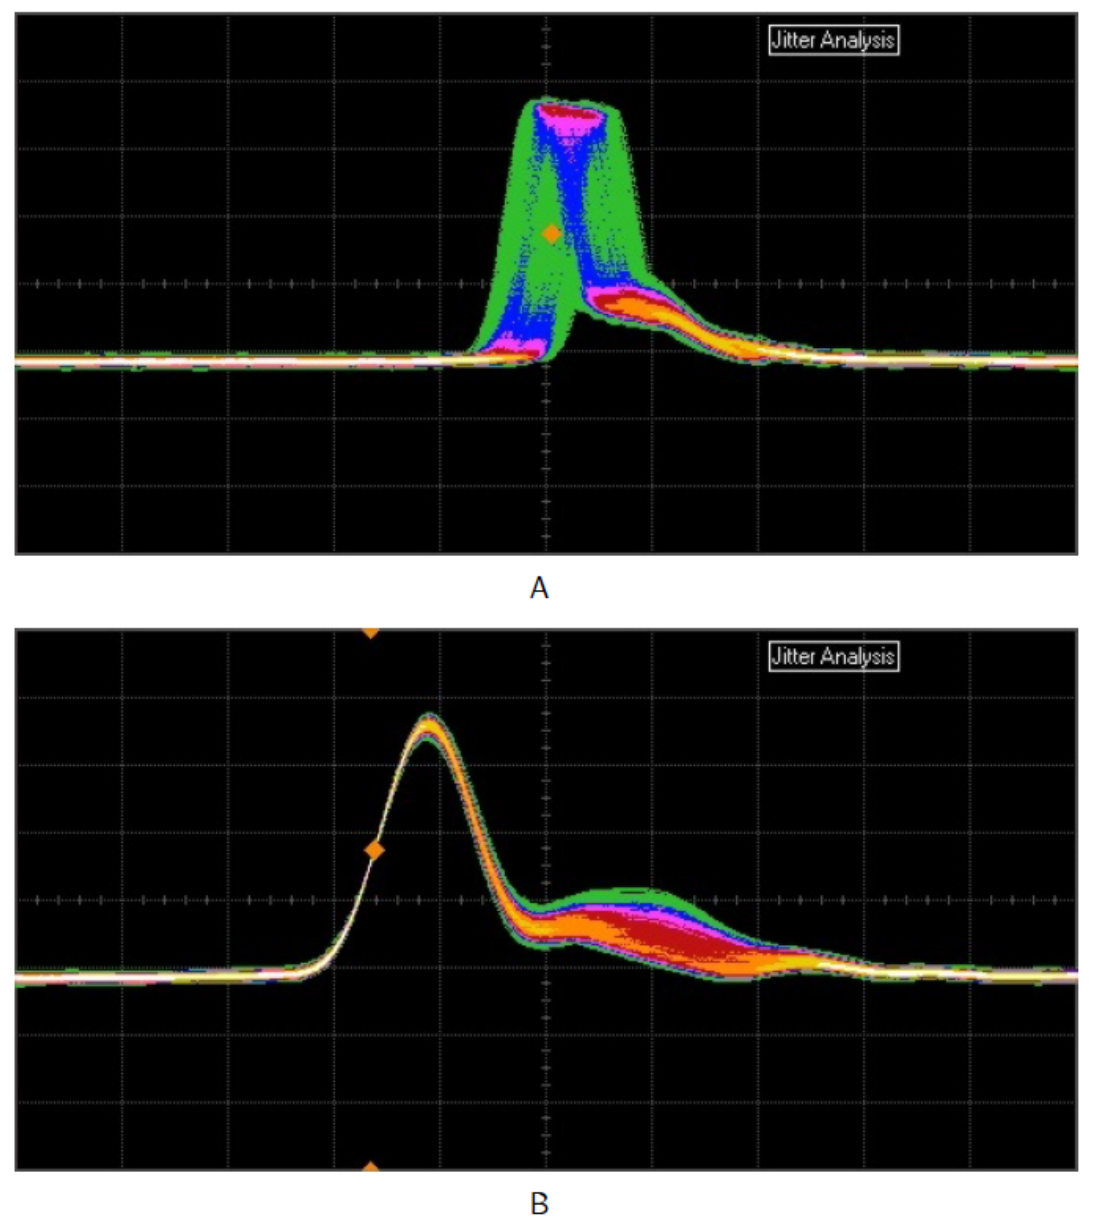
Figure 5. ( A ) 100 ps pulses aligned to the reference clock, 200 ps per division; ( B ) 100 ps pulses self-triggered, 100 ps per division